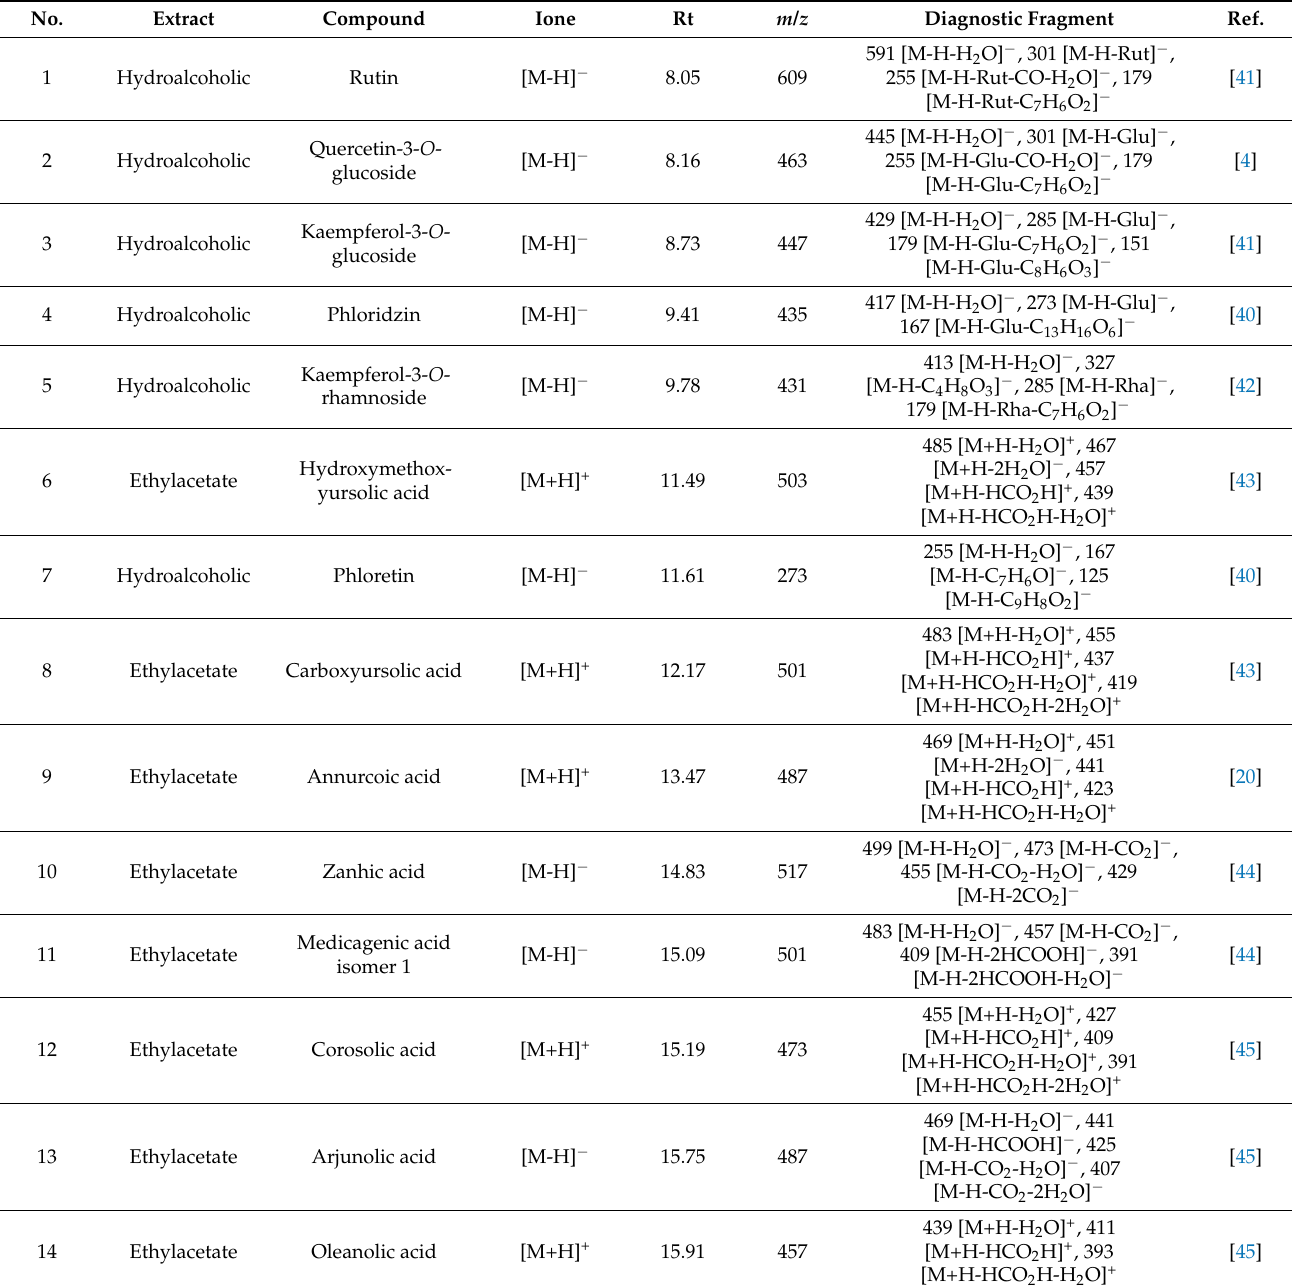
Table 3. HPLC-HESI–MS/MS analysis of OAAO hydroalcoholic and ethyl acetate